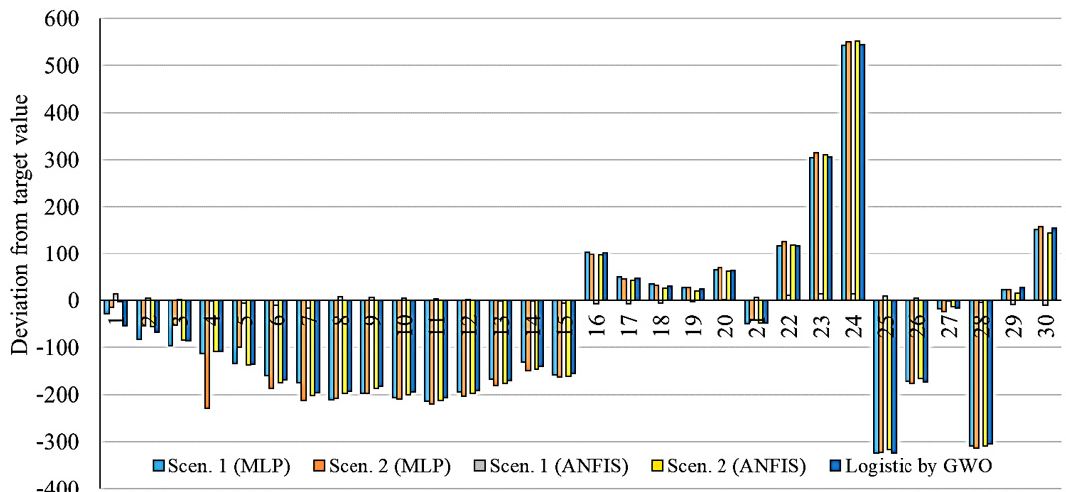
Figure 17. Deviation from target value for models related to Italy.